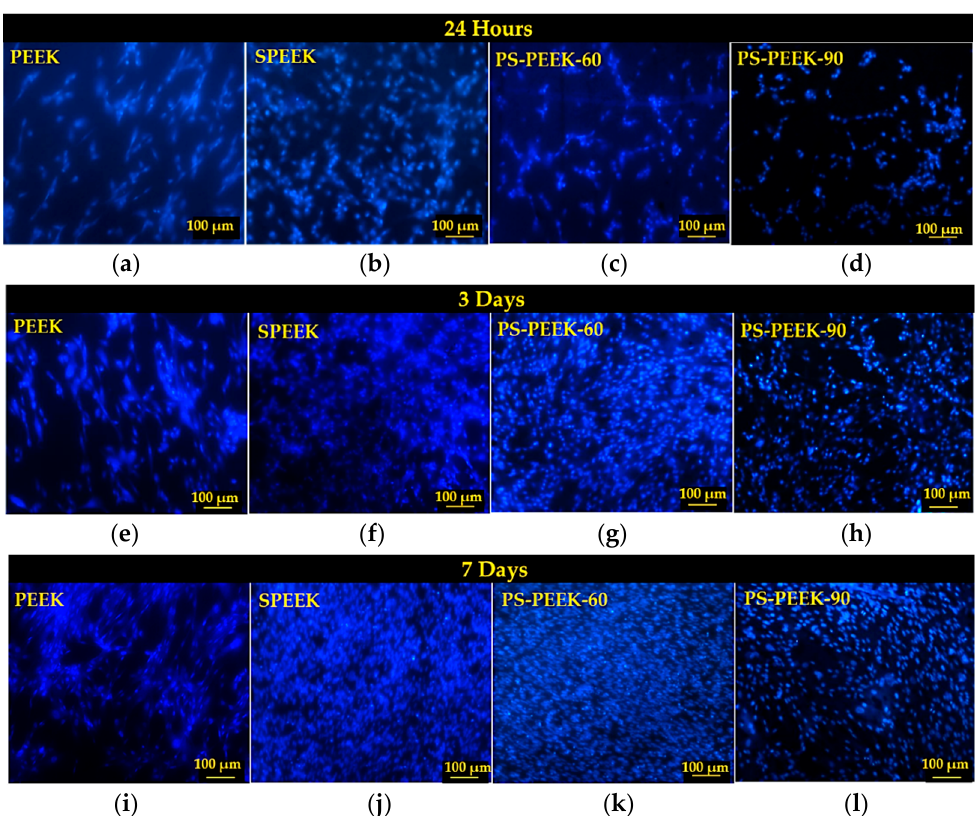
Figure 4. Cells stained with DAPI adhered to the surfaces of PEEK ( a – i ), SPEEK ( b – j ), PS-PEEK-60 ( c – k ) and PS-PEEK-90 ( d – l ) samples after 24 h, 3 and 7 days of growth.